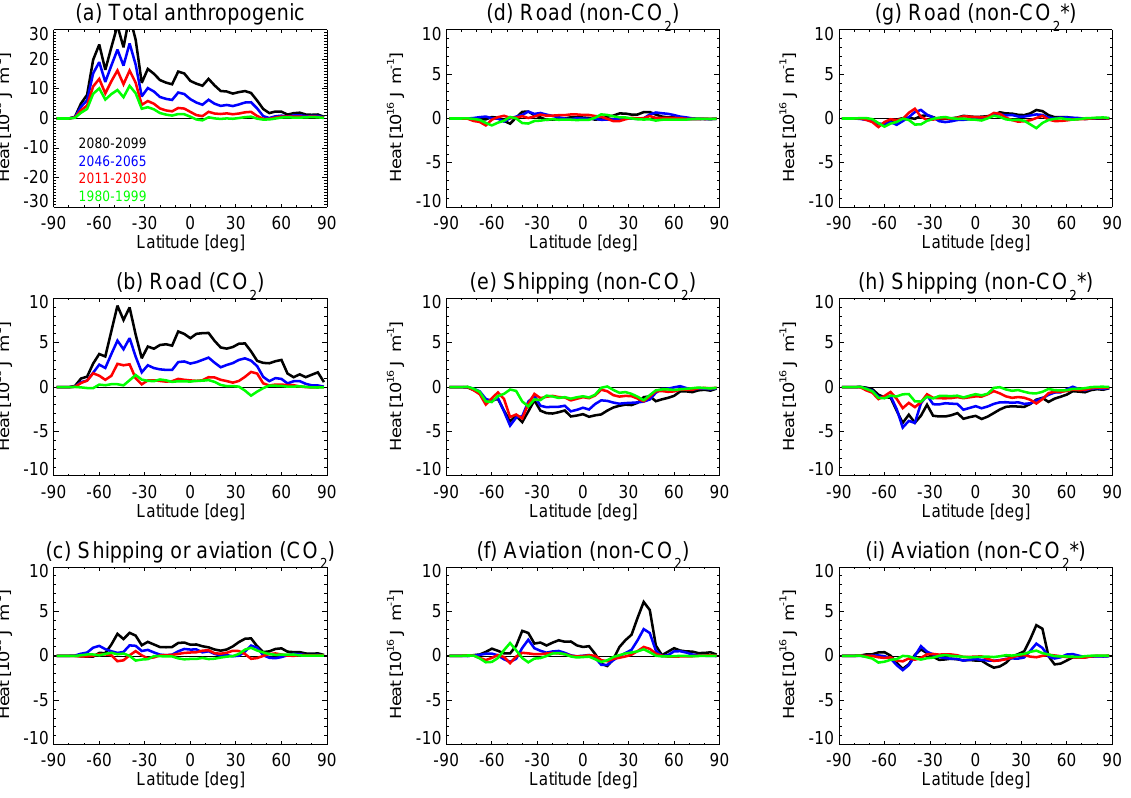
Fig. 19. Zonally integrated heat uptaken by the ocean (in 10 16 Jm − 1 ) in 1980–1999 (green), 2011–2030 (blue), 2046–2065 (red) and 2080–2099 (black). The order of the plots is as in Fig. 11.